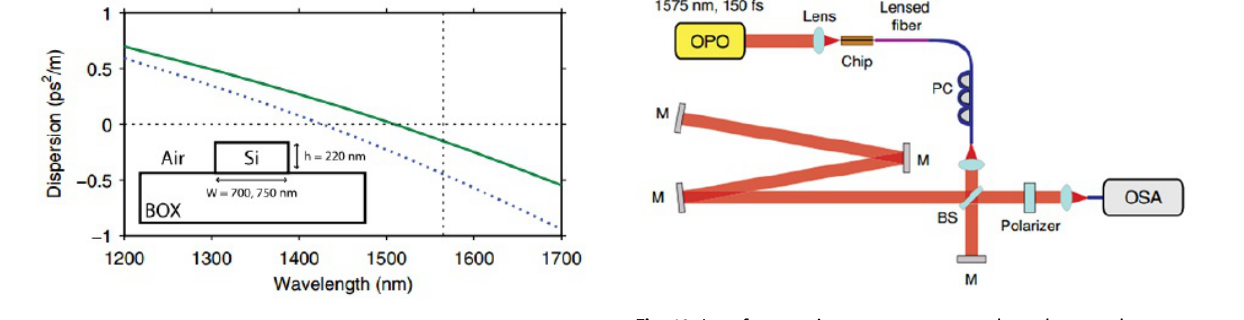
Fig. 8. The group velocity dispersion of the fundamental TE mode of a silicon waveguide as a function of wavelength for a 700 nm wide waveguide (dotted line) and a 750 nm wide waveguide (solid line). The inset shows the waveguide cross-section. Adapted from reference [26].